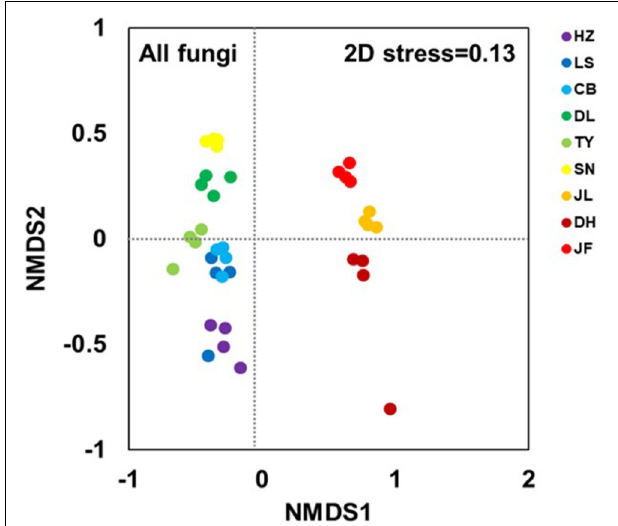
FIGURE 2 | Non-metric multidimensional scaling (NMDS) based on Bray-Curtis distance at the OTU level illustrating soil fungal community structure. Abbreviations for sampling sites from north to south are as follows: HZ, Huzhong; LS, Liangshui; CB, Changbai; DL, Dongling; TY, Taiyue; SN, Shennong; JL, Jiulian; DH, Dinghu; and JF,